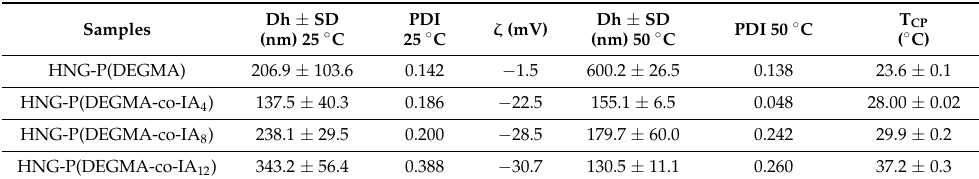
Table 4. HNGs synthesized starting from constant amount of MSN@MEMO, DEGMA, and increasing percentage of